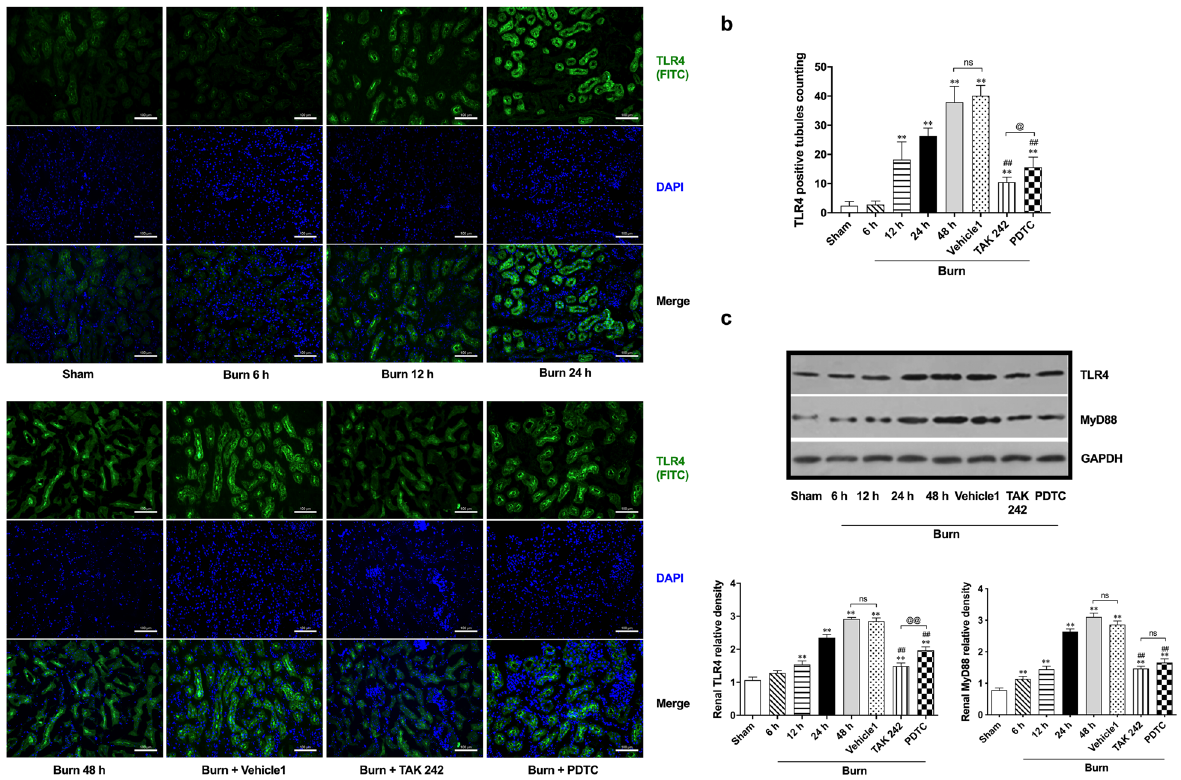
Figure 2. Immunofluorescent and immunoblotting detection of TLR4 pathway. ( a ) Immunofluorescence double staining of TLR4; ( b ) The double-blind counting of TLR4 positively-stained tubules (green-labeled), n = 12 per group; ( c ) Representative bands of Western blot on TLR4 and MyD88, n = 6 for each group. The results are expressed as the mean ± SD. * p < 0.05, ** p < 0.01, v.s. sham; # p < 0.05, ## p < 0.01, v.s. vehicle1; @@ p < 0.01, ns p >